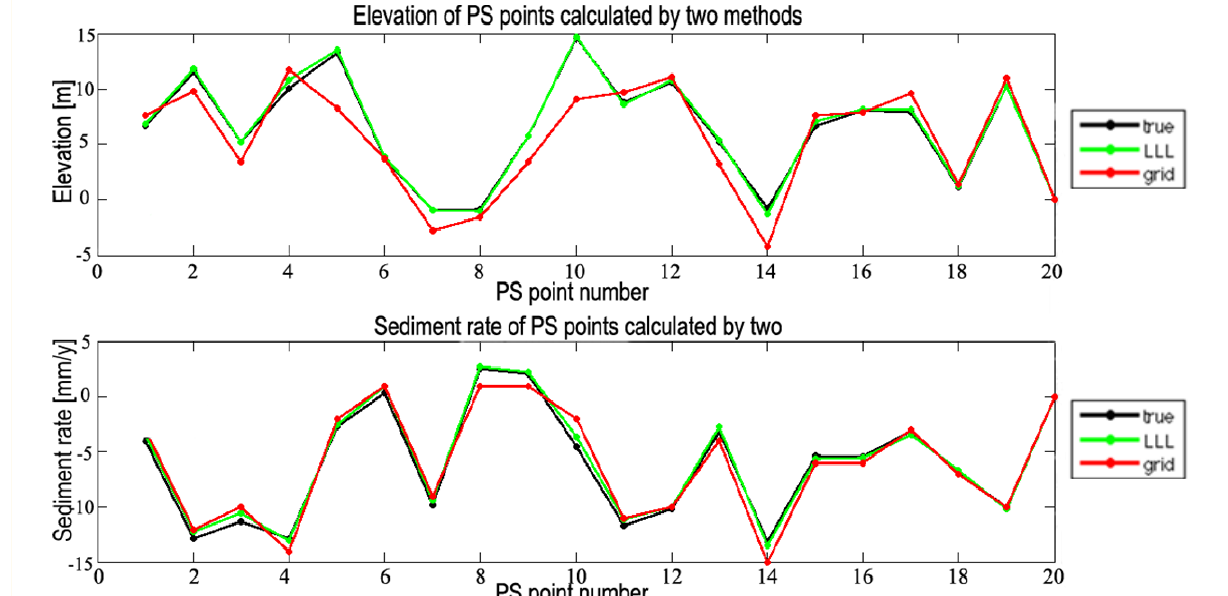
Figure 9 Elevation and sediment rate of PS points calculated by two methods before